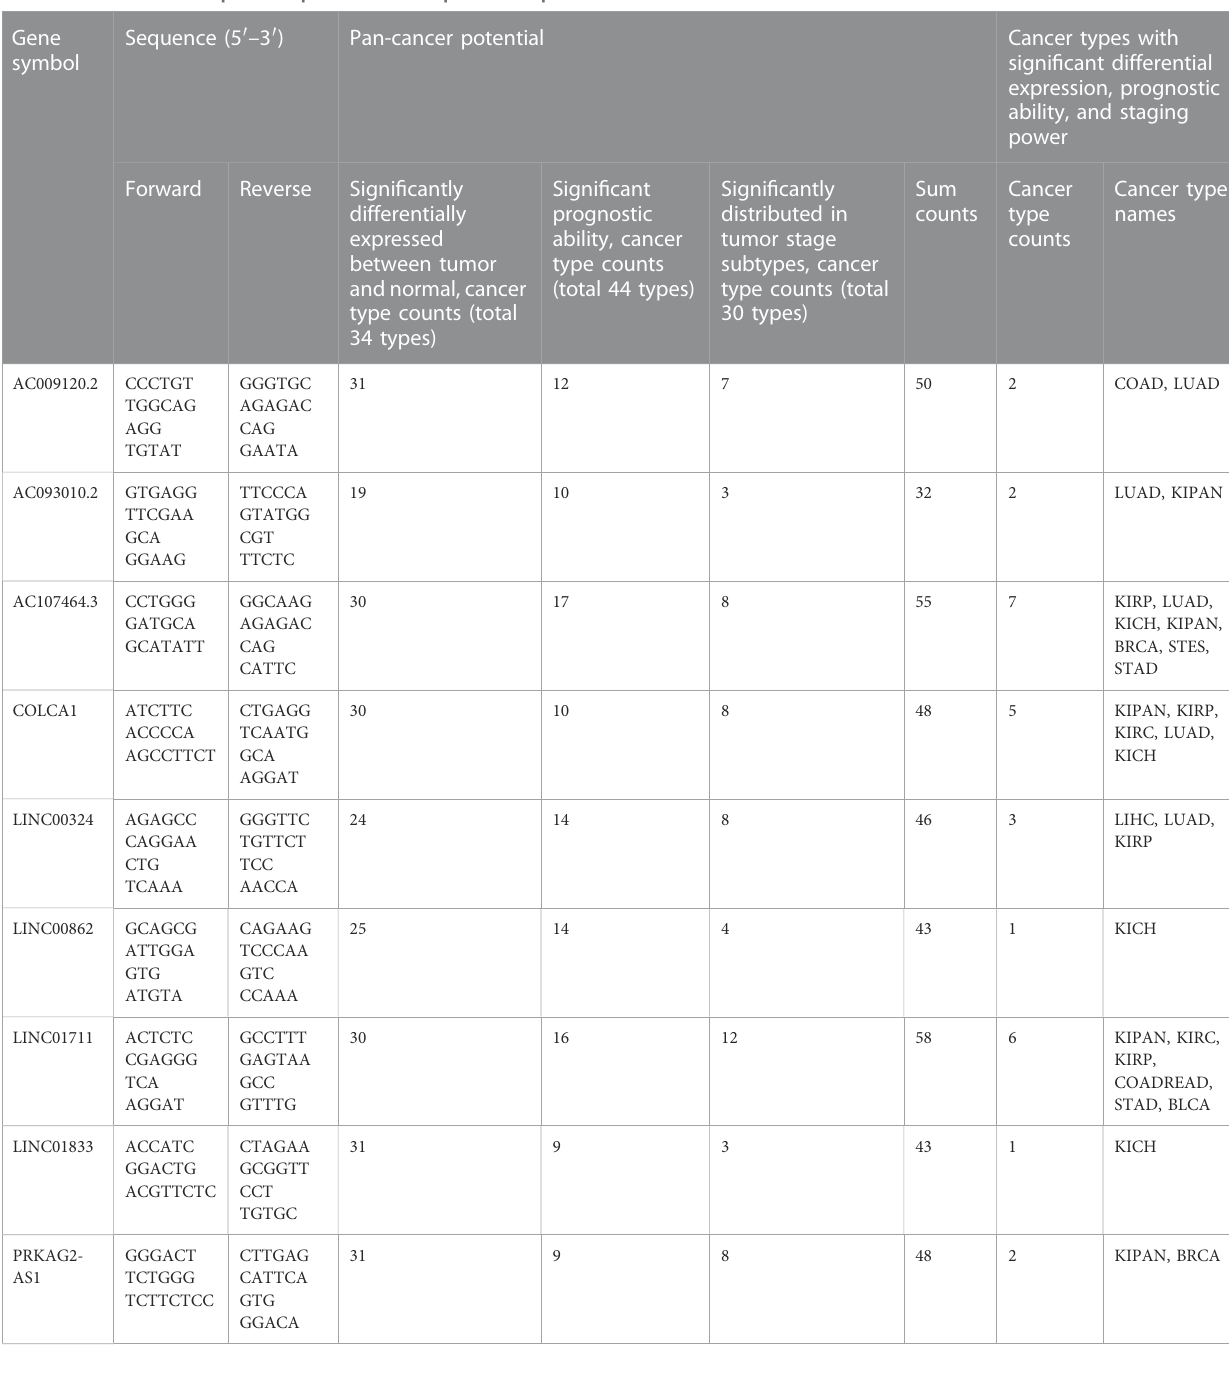
TABLE 3 The nine lncRNAs ’ primer sequences and their potential in pan-cancer. Gene Sequence (5 ′ – 3 ′ symbol